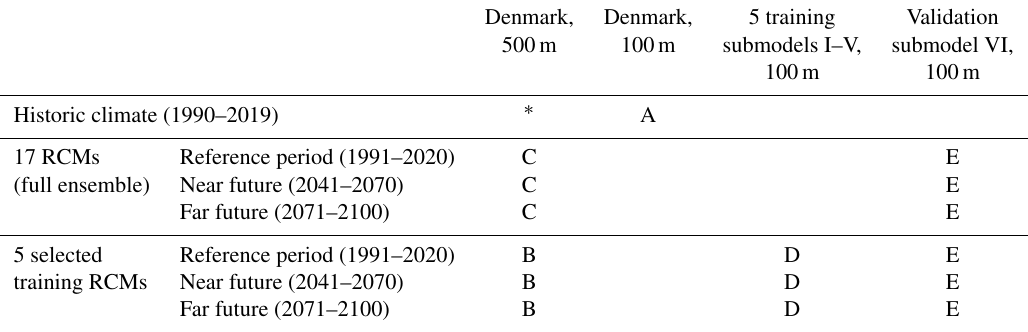
Table 2. Overview of the performed HM runs with different climate inputs for Denmark and different submodels. A – used as covariate. B – to be downscaled, in training, and as additional training data (auxiliary points). C – to be downscaled, in validation. D – training data. E – validation data. ∗ : Not directly used in this